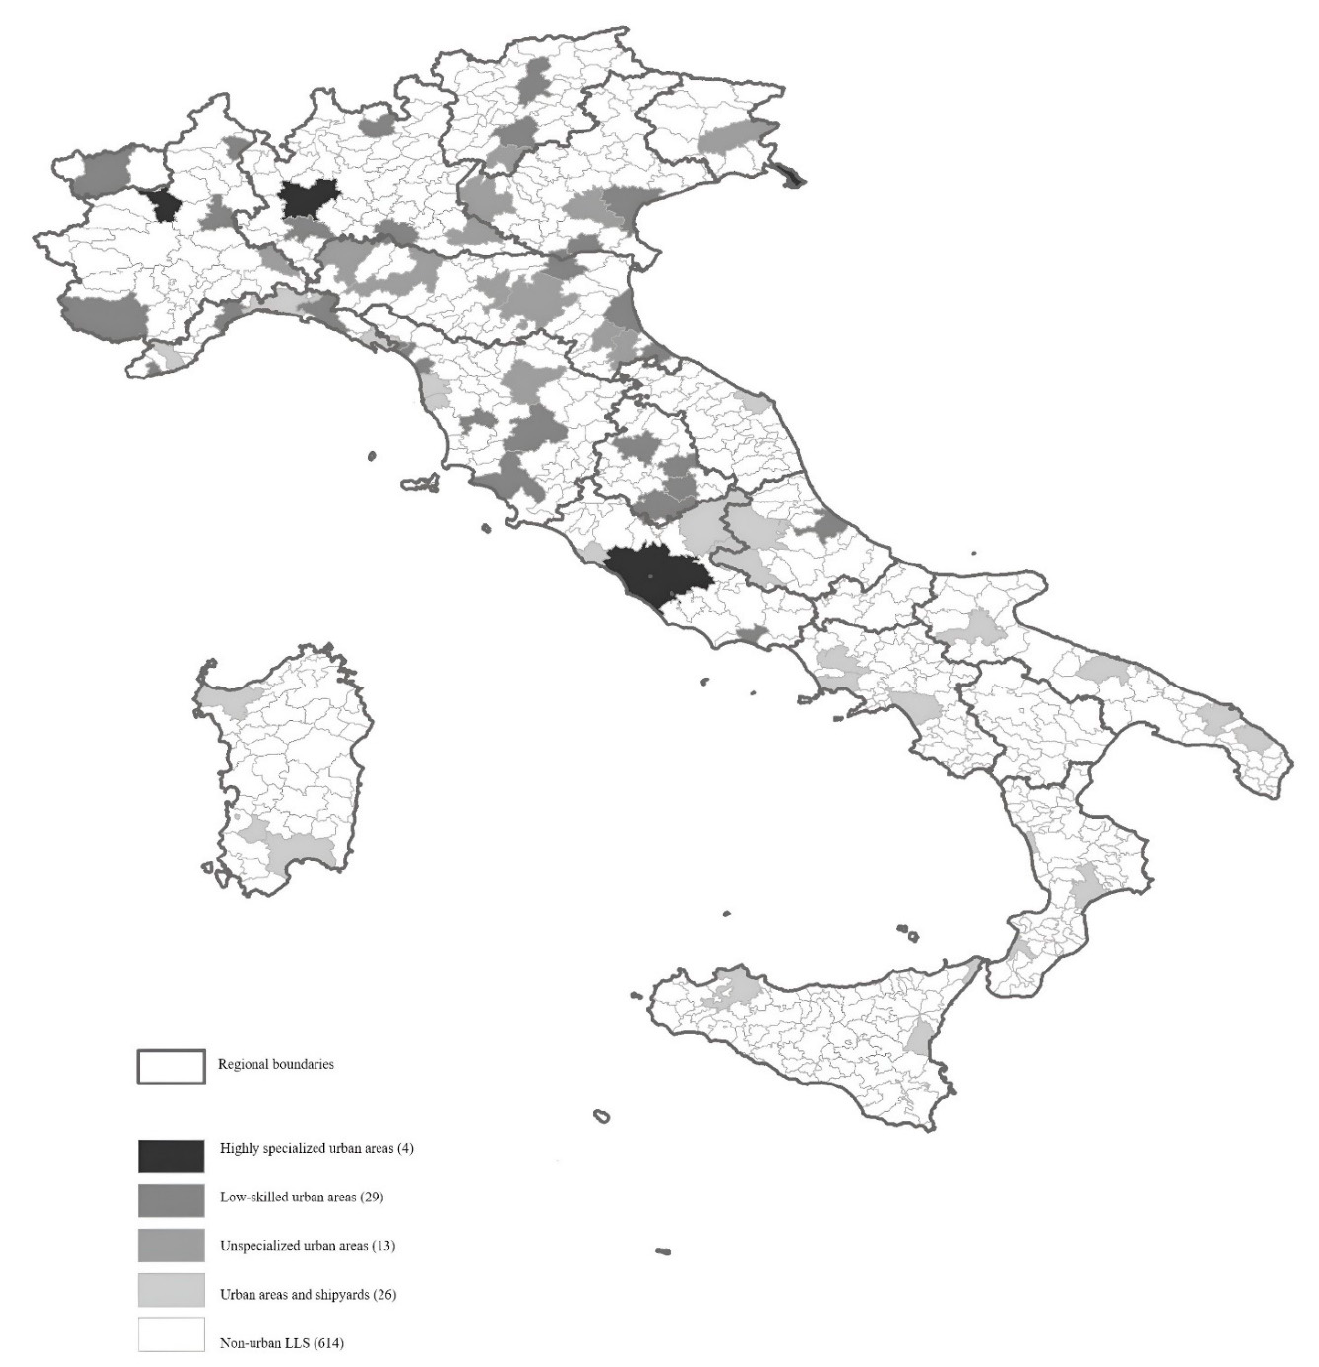
Figure 3. The representation of Italy after applying the Barbieri and Cruciani method. Territorial classification for each LLS existing in Italy. Source: Barbieri and Cruciani, 2007.